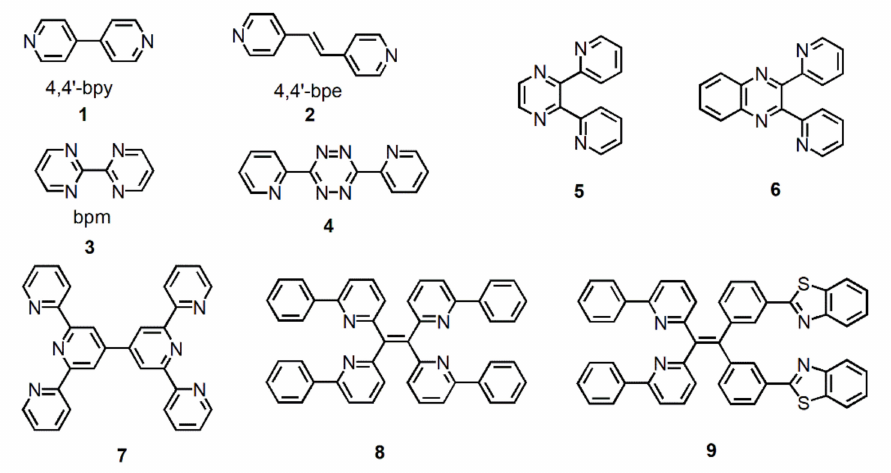
Figure 2. Some polypyridine bridging ligands mentioned in this chapter. Although 2,2 (cid:48) -bipyridine is an isomer of 4,4 (cid:48) -bipyridine, its two nitrogen atoms